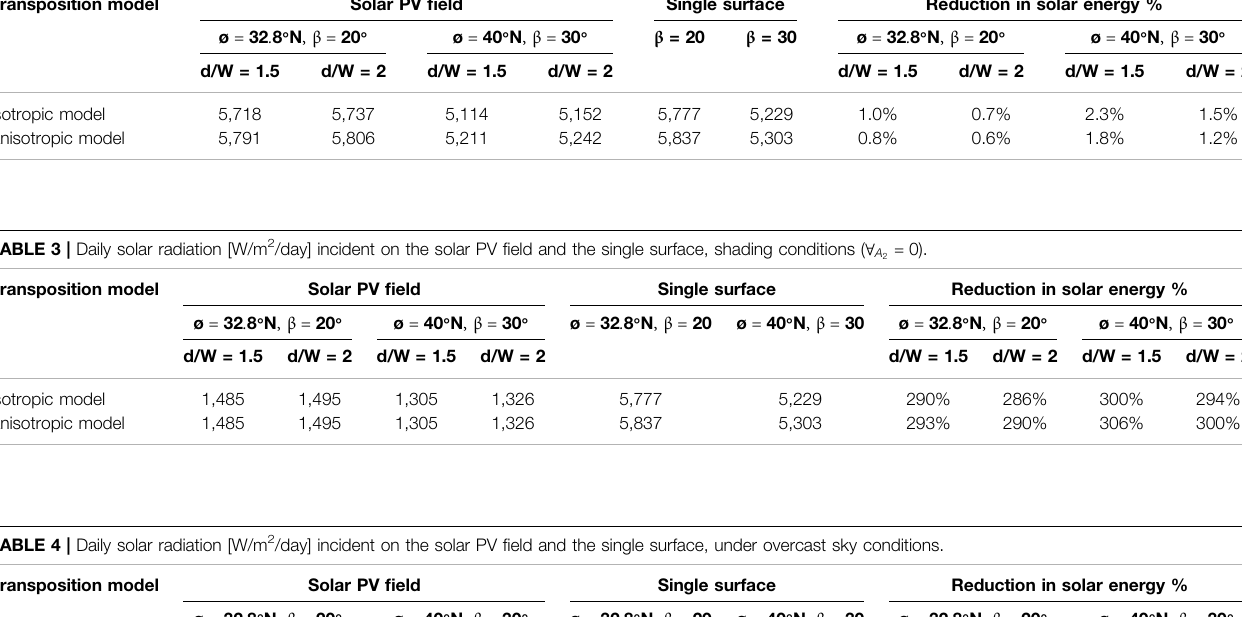
TABLE 2 | Daily solar radiation [W/m 2 /day] incident on the solar PV fi eld and the single surface, no shading conditions. ( ∀ A Transposition model Solar PV fi eld Single surface